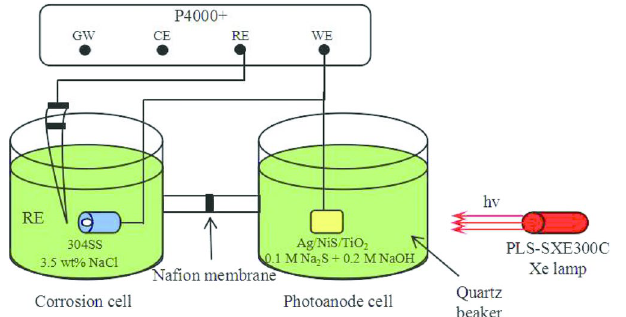
Figure 2. Schematic illustration of the experimental set-up for measuring photoinduced potential.